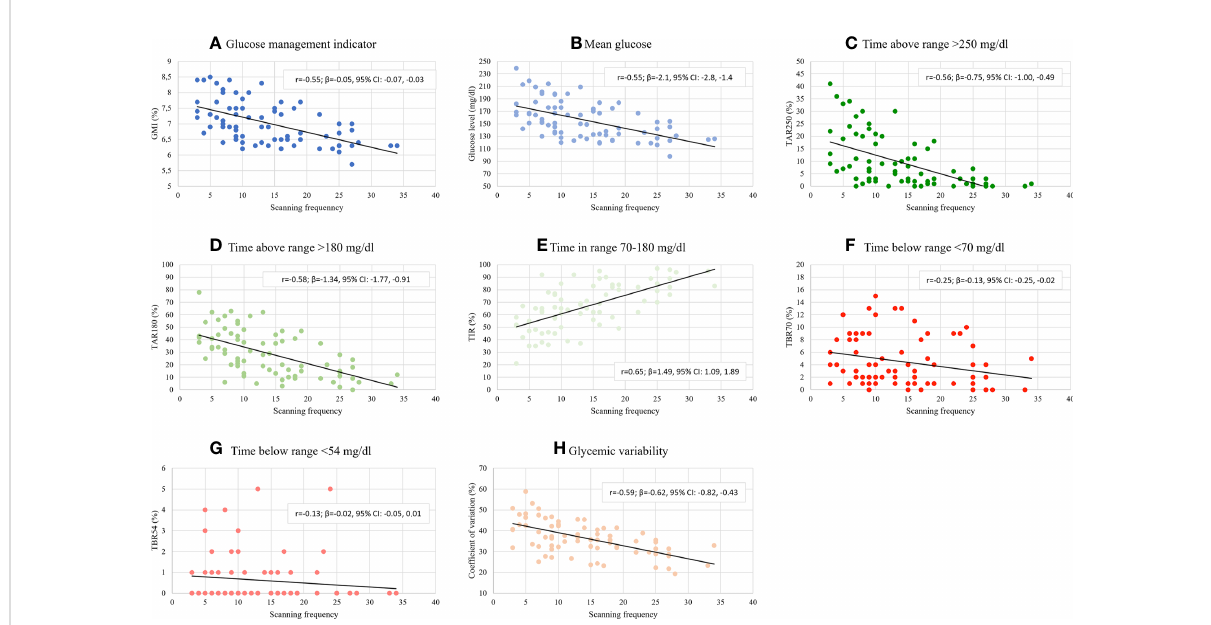
FIGURE 2 Glycemic indices by scanning frequency. (A) Glucose management indicator, (B) Mean glucose, (C) Time above range >250 mg/dl, (D) Time above range >180 mg/dl, (E) Time in range 70-180 mg/dl, (F) Time below range <70 mg/dl, (G) Time below range <54 mg/dl, (H) Glycemic variability expressed as coef fi cient of variation. b - beta coef fi cient, r - Pearson correlation coef fi